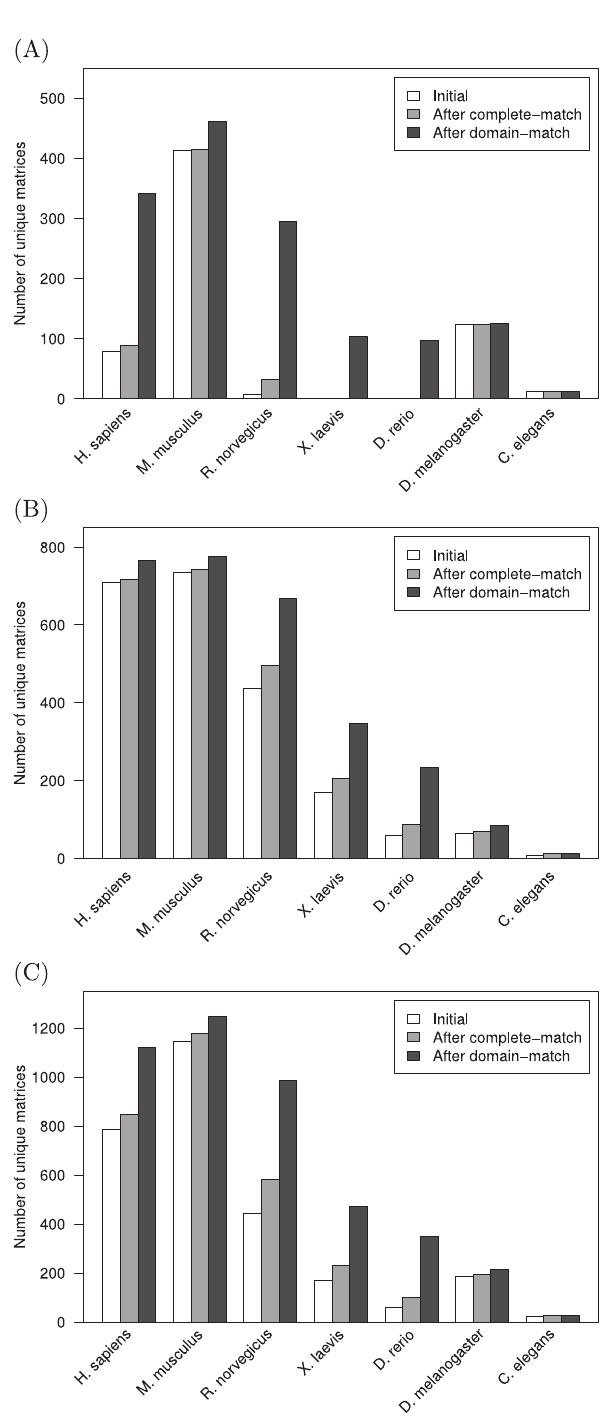
Figure 2. The number of position weight matrices for select organisms before and after homology mapping. The number of matrices that are initially associated with each organism is compared to the number following mapping of transcription factors with complete- ly-identical sequences, as well as the increase following identical DNA binding domain-level mapping for the (A) JASPAR, (B) TRANSFAC, and (C) JASPAR & TRANSFAC databases. The JASPAR and TRANSFAC databases initially contained PWMs from 124 different species, compared to 1578 species following domain-level homology mapping. In particular, significantly increased PWM coverage is possible through domain-level mappings for the open-access JASPAR database.